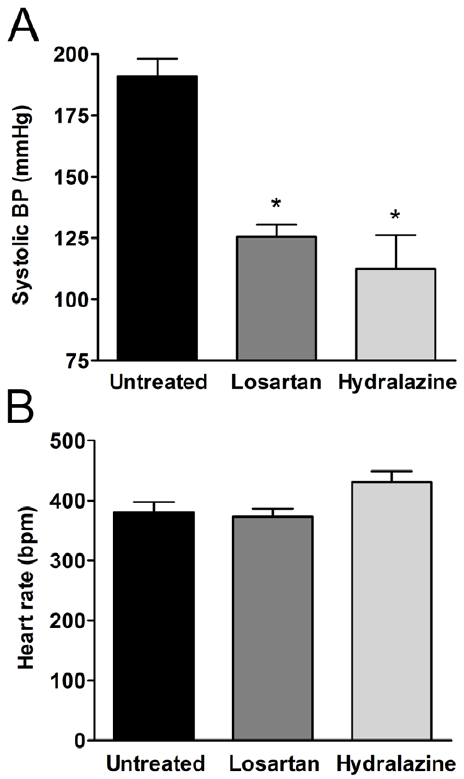
Figure 1. Losartan and hydralazine lower blood pressure in SHR. Hemodynamic parameters of SHR after four weeks untreated or treated with losartan or hydralazine. ( A ) systolic blood pressure; ( B ) corresponding heart rate. Data are expressed as mean 6 SEM, n=4–6, * p , 0.05 compared to untreated.